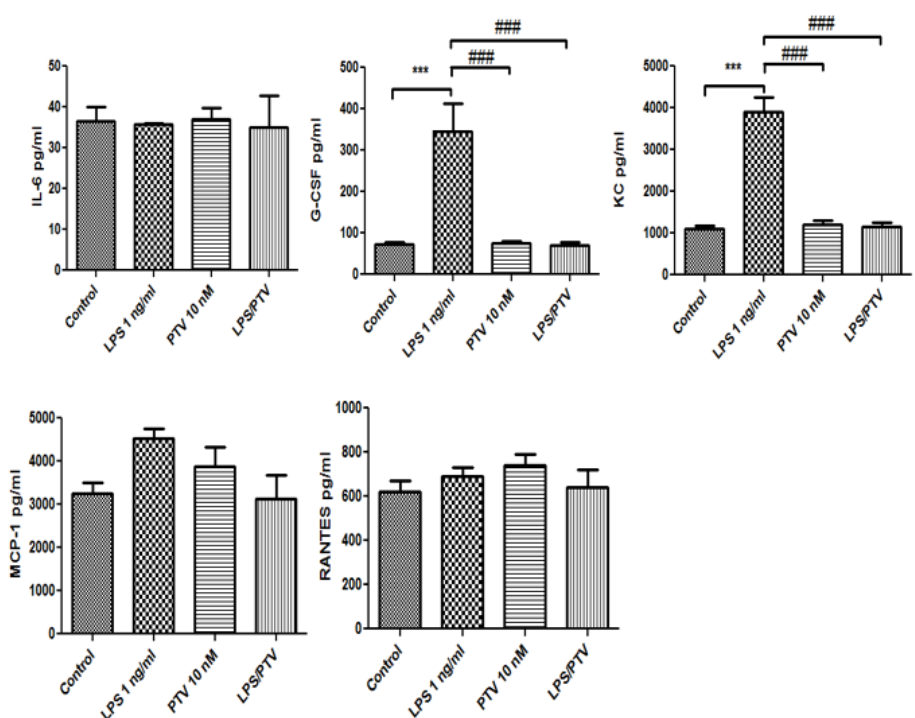
Figure 4. LPS increased the release of G-CSF and KC from the in vitro BBB model into the abluminal chamber, and PTV inhibited the LPS-induced release of these cytokines. The addition of LPS to the luminal chamber did not induce significant increases in the secretion of other cytokines in the abluminal chamber. *** p < 0.001 vs. control; ### p < 0.001 vs. LPS (two-way ANOVA).